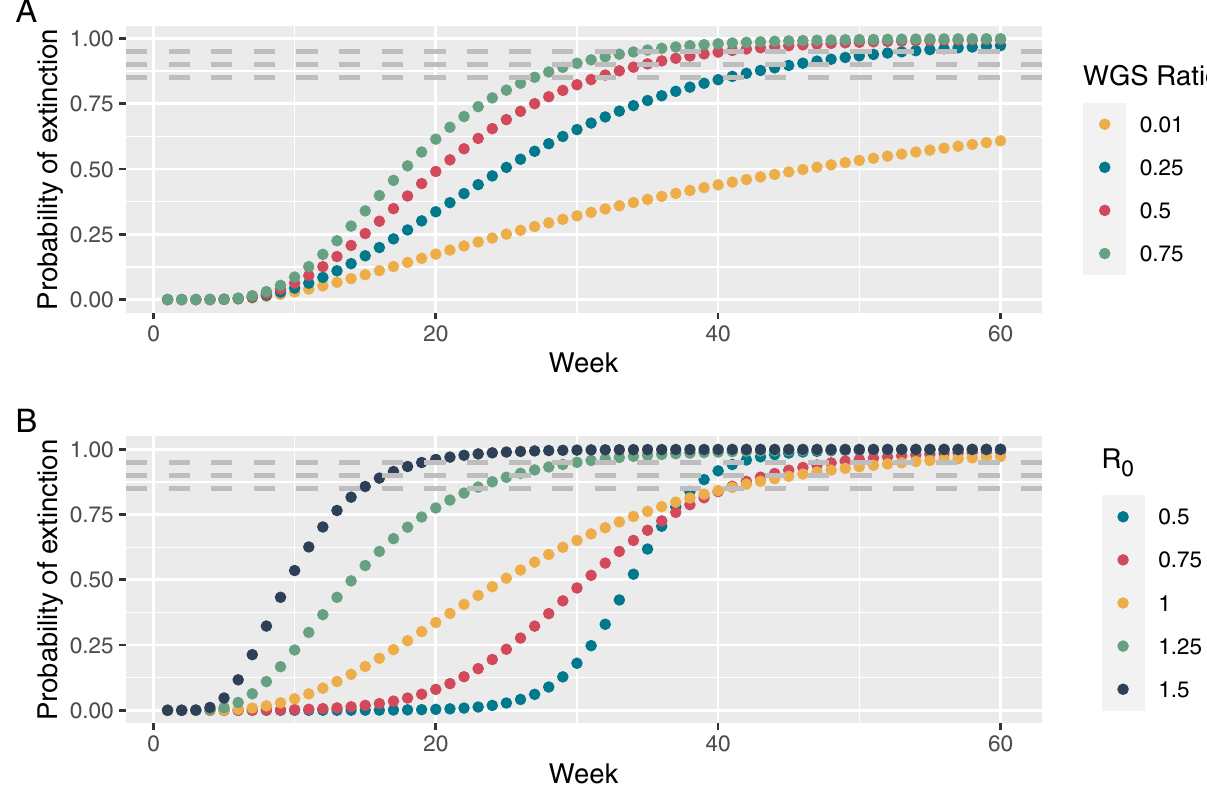
Figure 1. Probability of extinction as a function of the number of weeks with no observations of the specific variant. Dashed lines indicate probability levels 0.85, 0.90, and 0.95, respectively. ( A ) Variation of testing regime for a constant reproduction rate of R 0 = 1 . ( B ) Variation of restrictions ( R 0 ) for a constant WGS testing ratio of 0.25. The blue curve in upper plot is the same as the yellow curve in the lower plot.